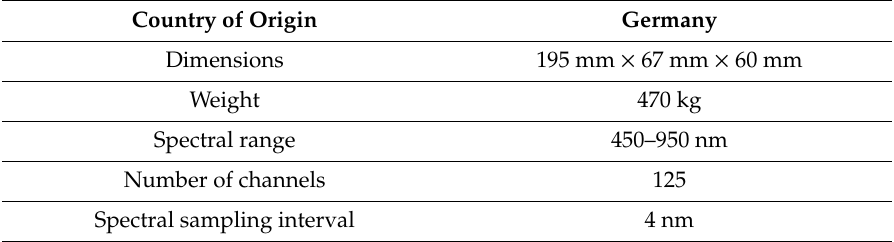
Table 1. Main attributes of the Ultra high definition (UHD) 185-Firefly hyperspectral sensor.